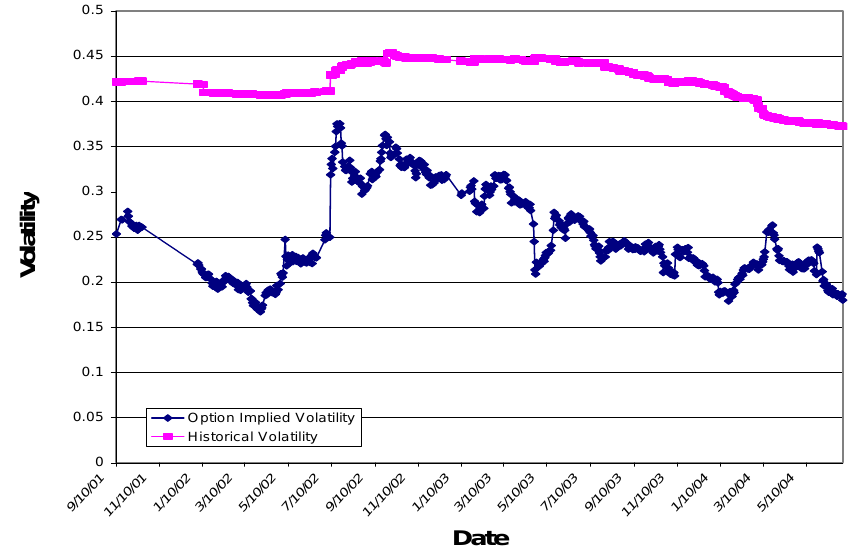
Figure 3. Wyeth, Implied Volatility vs. Historical Volatility Figure 3 Compares Implied volatility and Historical Volatility. It demonstrates that historical volatility is a smooth curve while historical volatility has more sudden jumps. This confirms the intuition that option-implied volatility incorporates information more promptly than historical volatility.